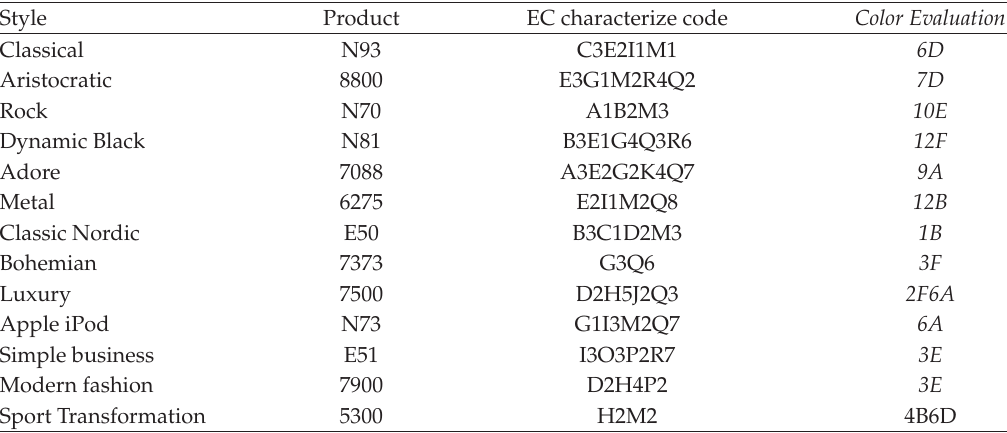
Table 6: Style description, representative product and kernel features codes (cid:2) Nokia (cid:3)